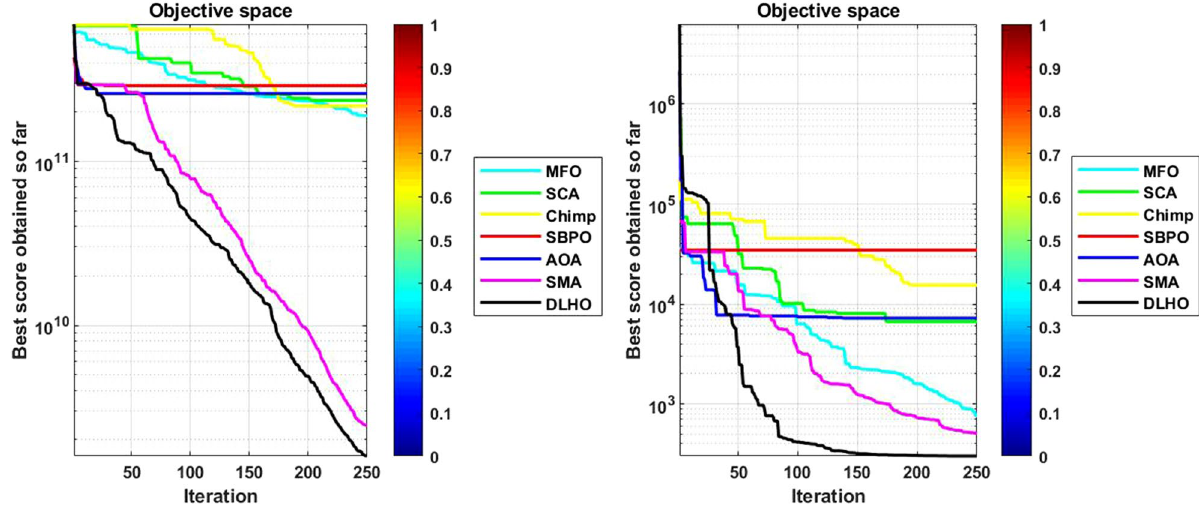
Figure 4. Performance graphs of Optimizers on uni-modal test